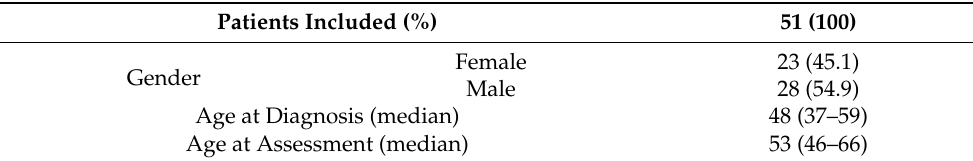
Table 2. Patient